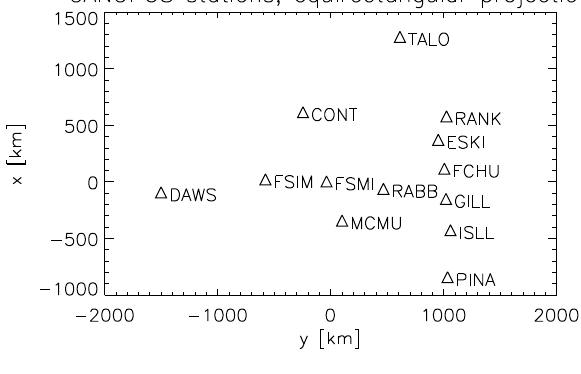
Fig. 1. Positions of the 13 stations of the CANOPUS array in equirectangular projection of the geomagnetic coordinate system. Positions of the geomagnetic North Pole and the reference point (RP) are given in the